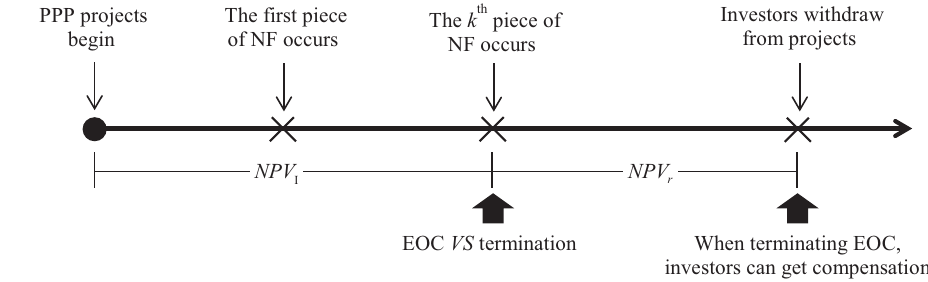
Figure 1. Time series of investors’ EOC in PPP projects